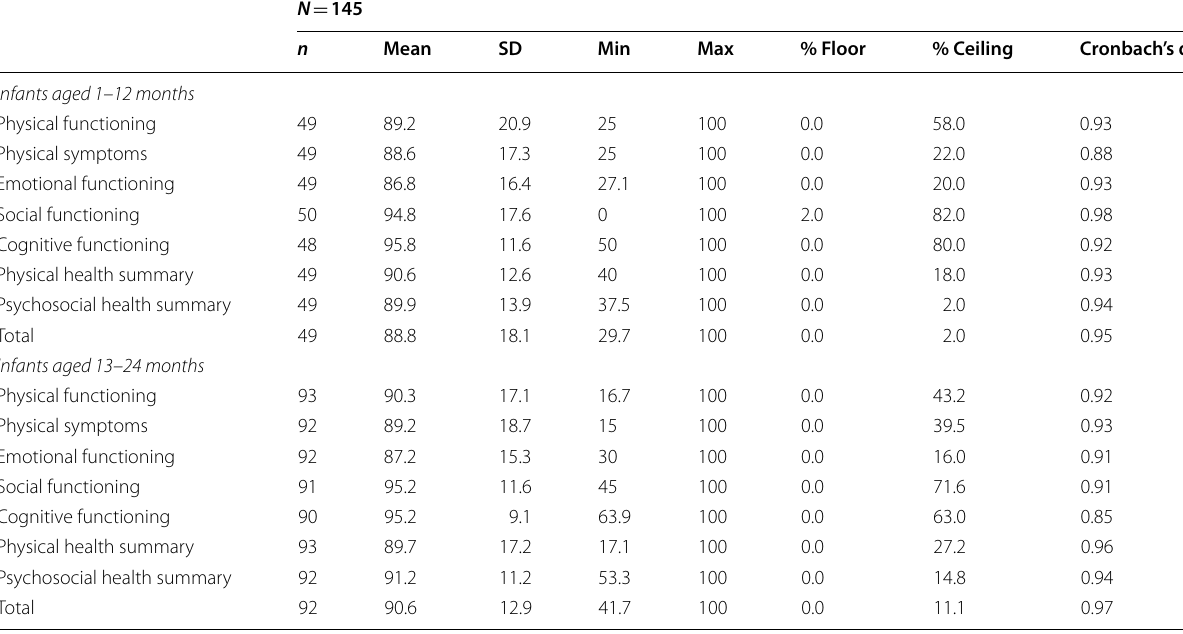
Table 2 Score distribution of the Japanese version of the PedsQL Infant Scales